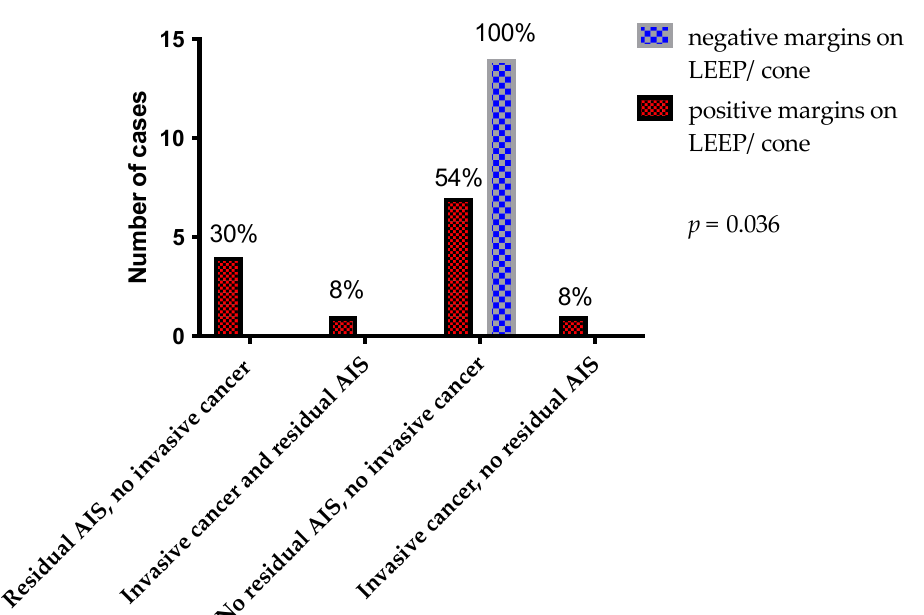
Figure 2. Presence of residual AIS or invasive cervical cancer in hysterectomy specimens, as stratified by conization margin status. Patients with negative conization margins had a significantly lower chance of having residual AIS and/or invasive cancer found in hysterectomy specimens (0% vs 46%) when analyzed with Chi-squared test, p = 0.036, Chi-square 4.42, df = 1). Table 2. Specimen margin status upon cervical conization as correlated with findings of residual disease on post-coniza- tion hysterectomy specimens.